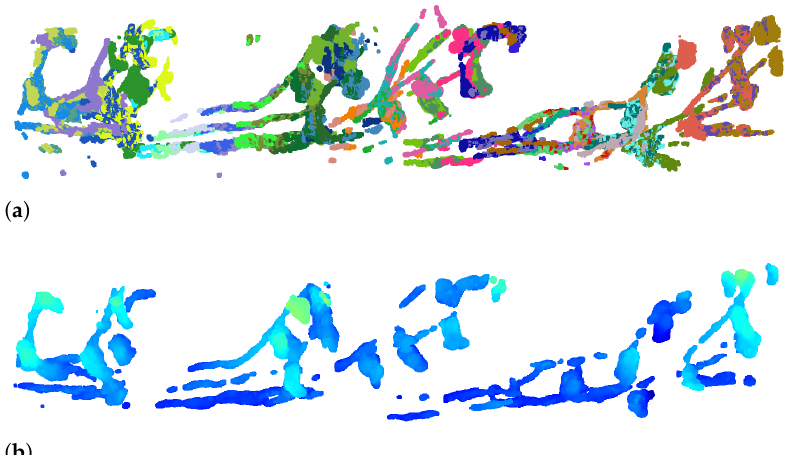
Figure 7. Images of a point cloud using 50 successive images of the greenhouse row before and after applying outlier removal. ( a ) Point cloud created using 50 successive images. The points from each image are displayed in a random colour. ( b ) Point cloud after outlier removal. Points are colourized based on distance from the camera, where blue-green points are closest to the camera (approximately 0.3 m), while dark blue points are farthest away (approximately 0.7